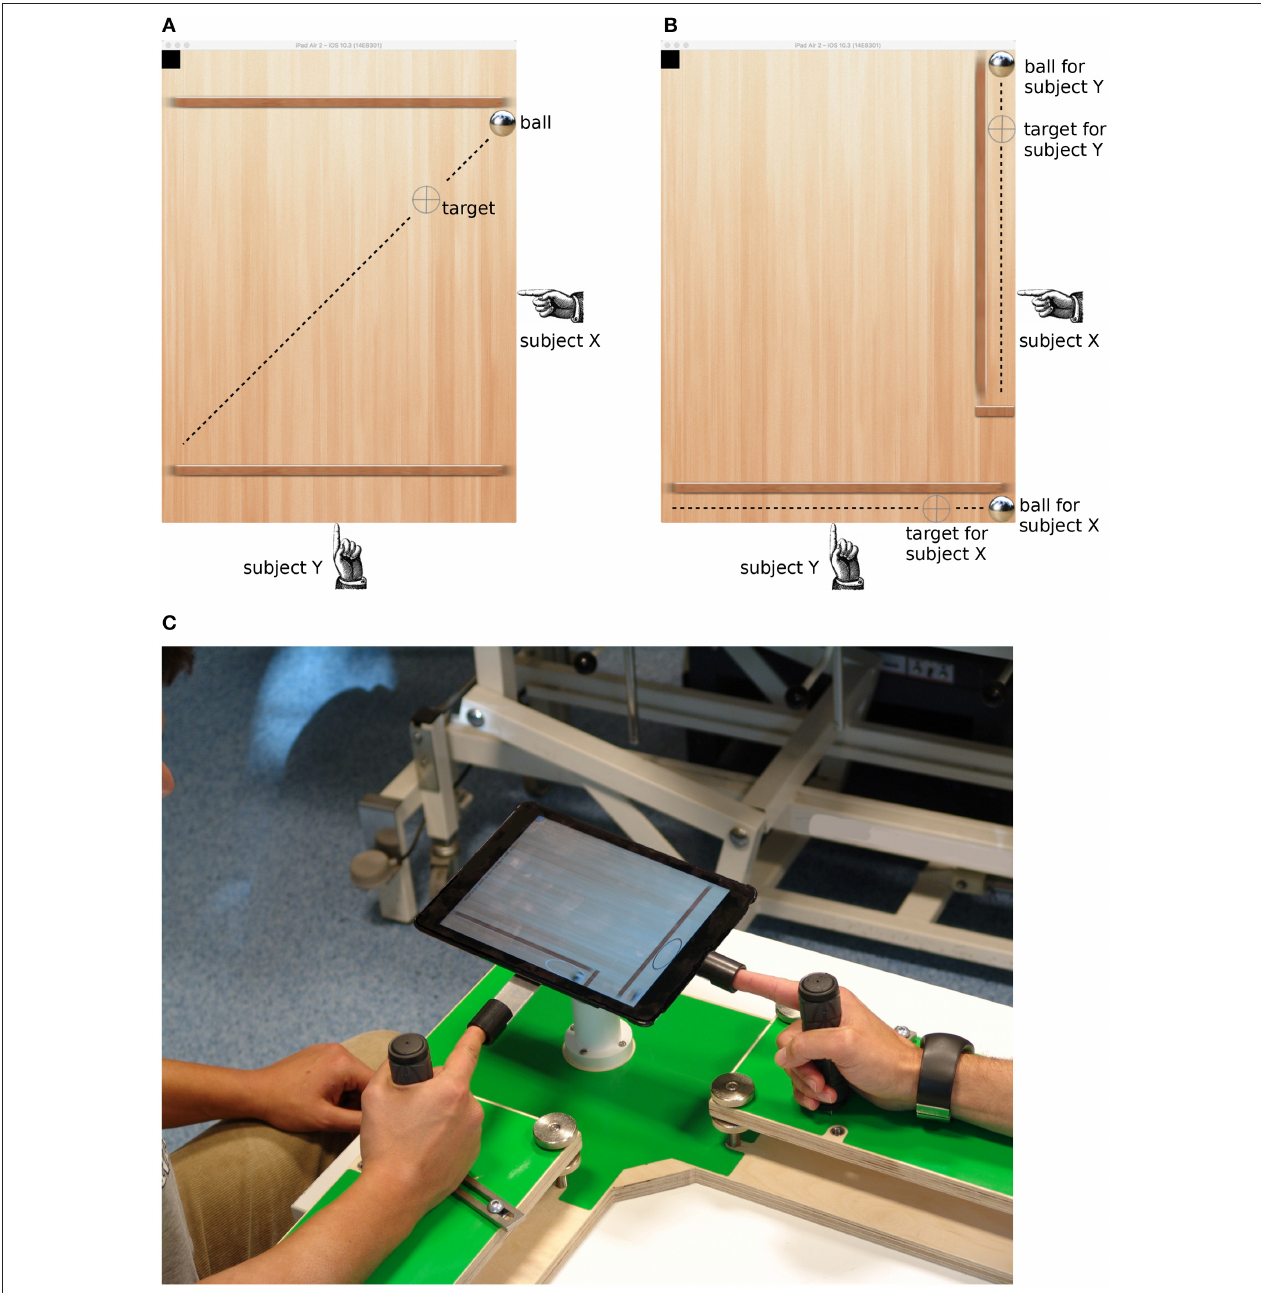
FIGURE 1 | Screenshots from the tablet computer showing the collaborative (A) and individual (B) conditions. The gray crosshair is the target that moved at constant rate along the dashed line (the line only illustrates the motion path; it was not visible to the subjects). Subjects tilted the tablet to make the ball roll to the target location. The black square in the upper left corner was used to synchronize the tablet with the amplifier and was not visible to the subjects. (C) Picture of the experimental setup.